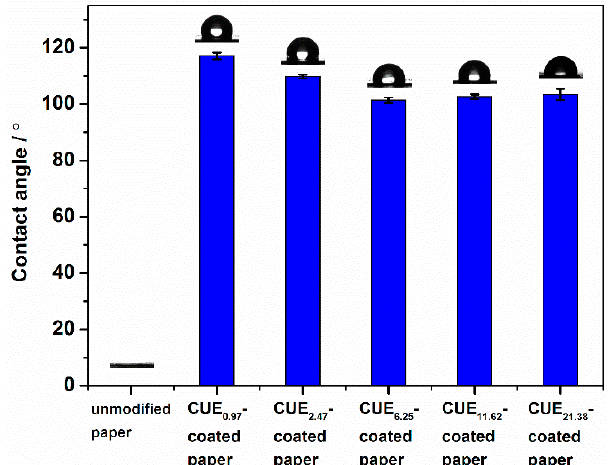
Figure 6. Contact angle of unmodified paper, CUE 0.97 -coated paper, CUE 2.47 -coated paper, CUE 6.25